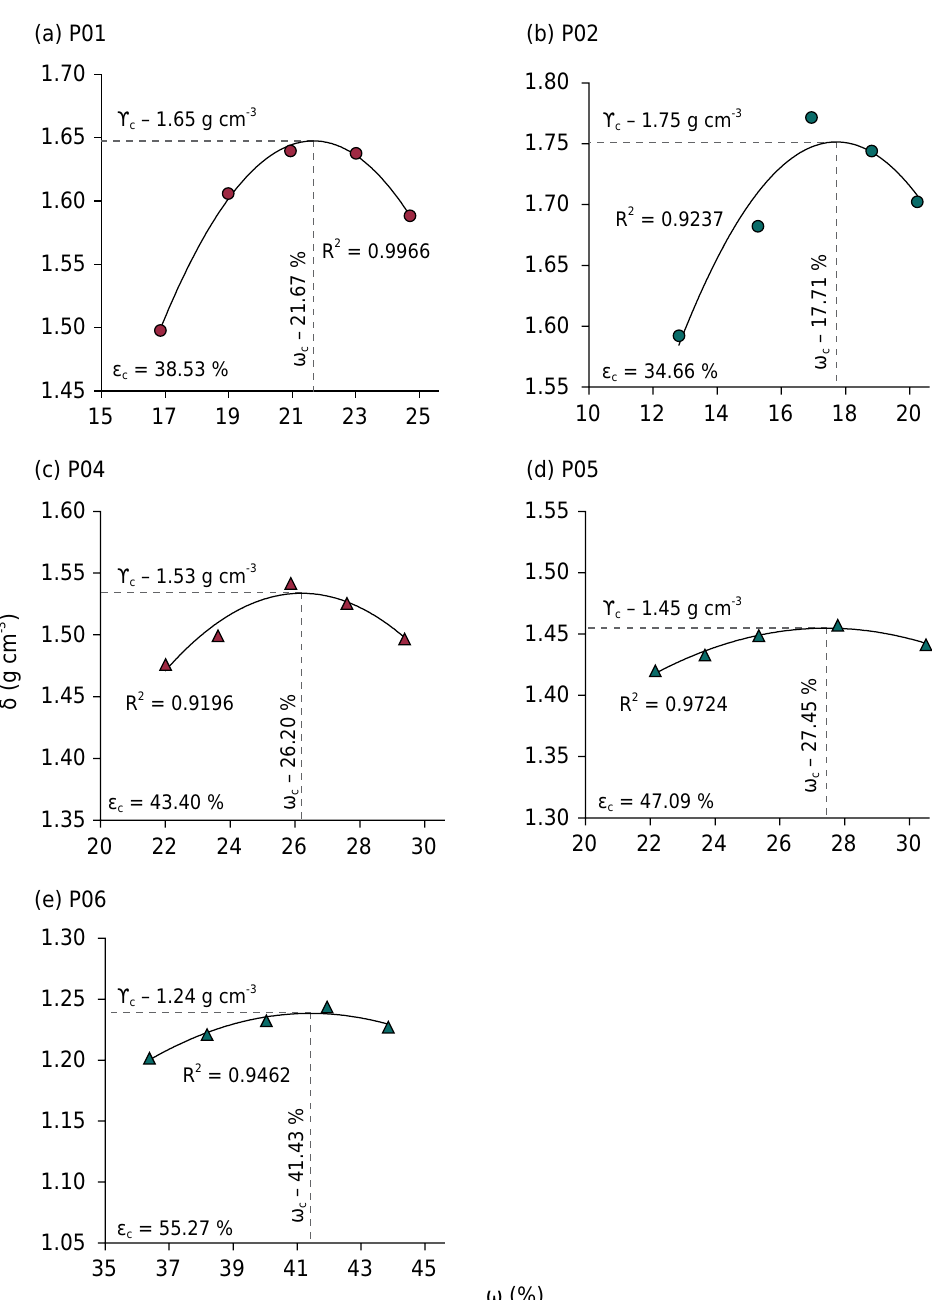
Figure 3. Compaction curve of Vertisols in Bahia State (δ: apparent specific mass of dry soil; ѡ: gravimetric moisture; ϒ c : maximum apparent specific mass; ѡ c : optimal compaction moisture; ε c : void index of soil at maximum compaction